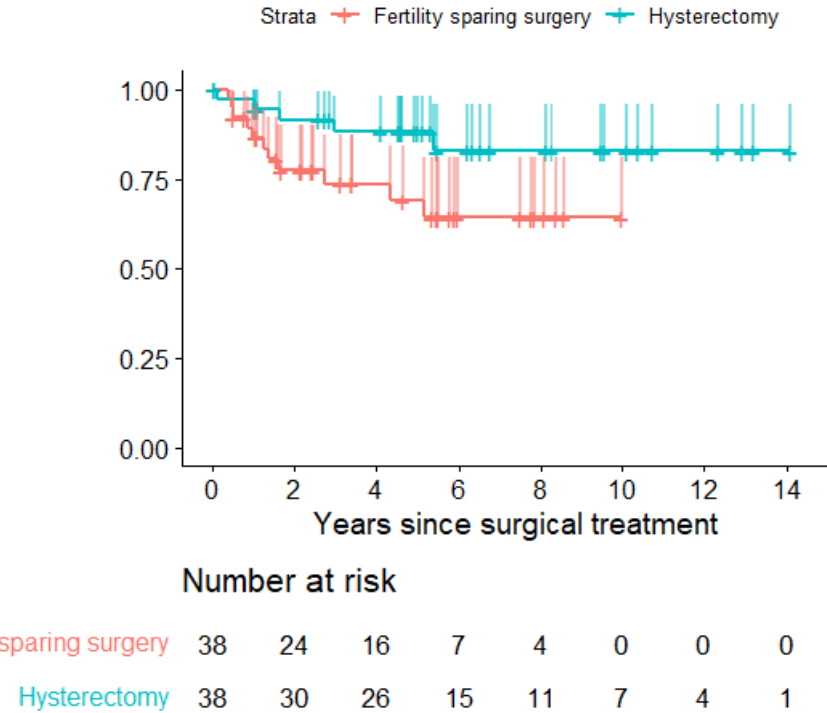
Figure 3. Kaplan–Meier disease-free survival curves. Tick marks indicate censored data. The vertical lines indicate the upper limits of the one-sided CI for noninferiority at 95%.